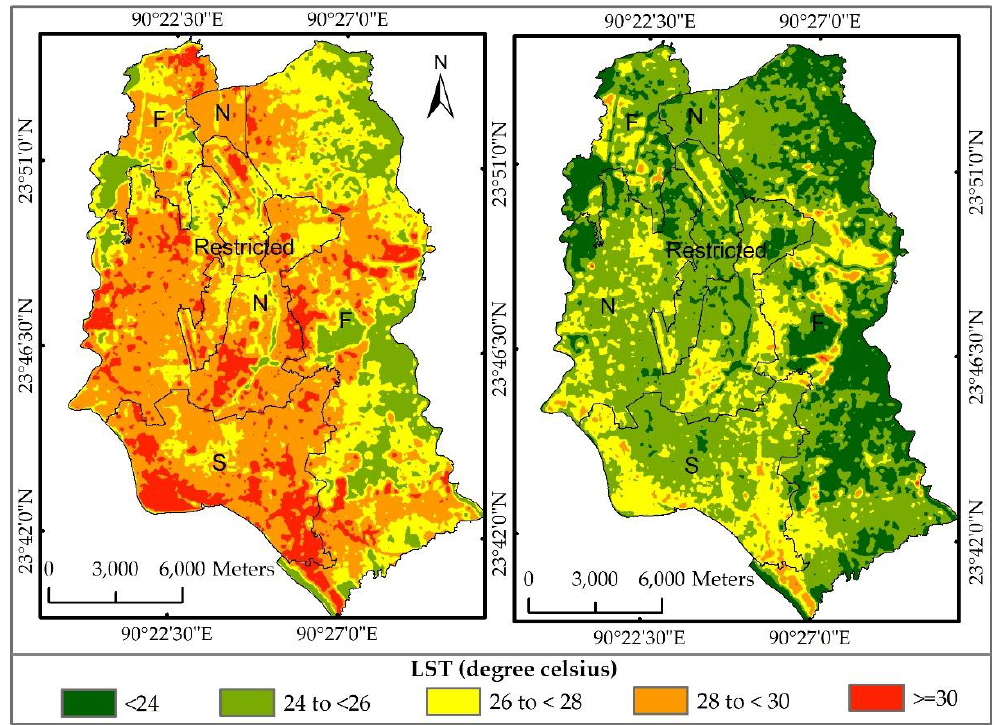
Figure 14. The average of summer (March to May 2014) land surface temperature (LST) (left) and the average of winter (November 2013 to February 2014) LST (right) in the map N, S, and F refer to DNCC, DSCC, and fringe area, respectively.